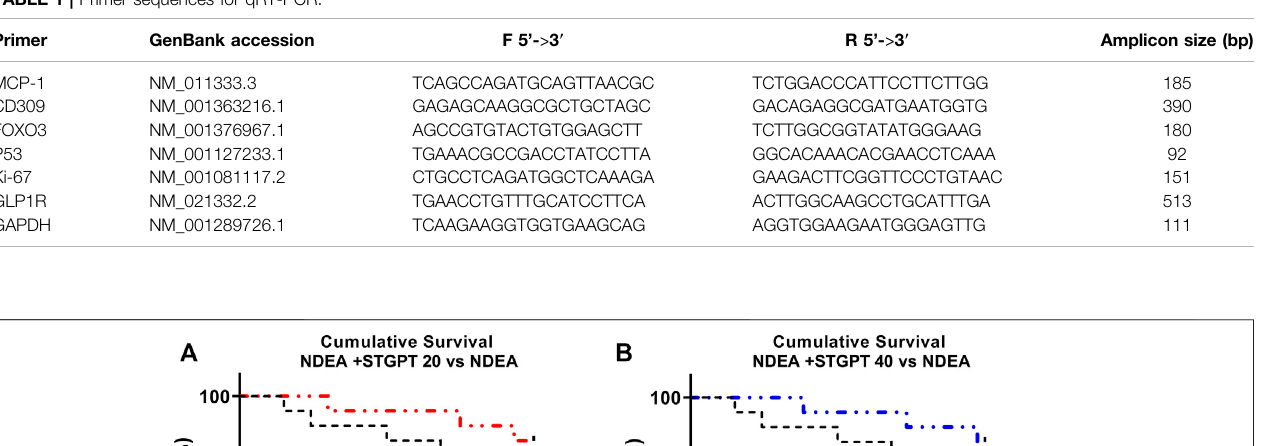
TABLE 1 | Primer sequences for qRT-PCR.